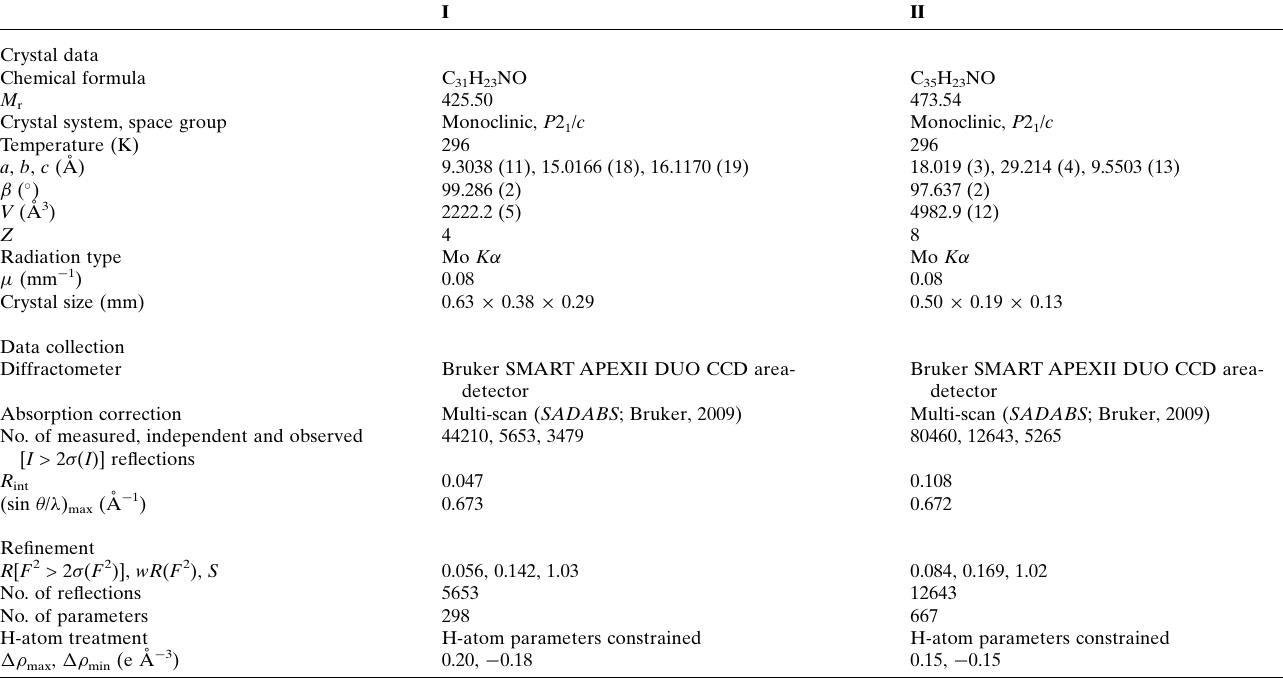
Table 2 Experimental